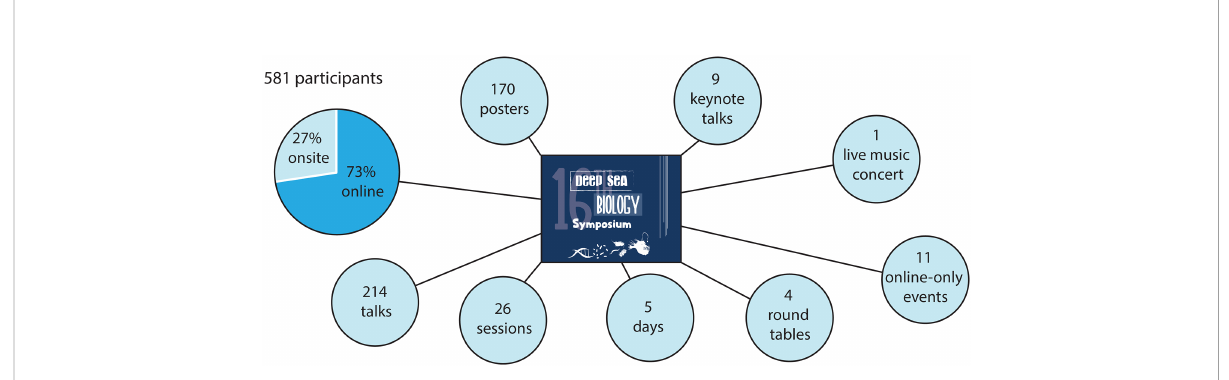
FIGURE 1 Summary of attendance and content of the hybrid conference 16DSBS. The 26 scienti fi c sessions were presented in two parallel